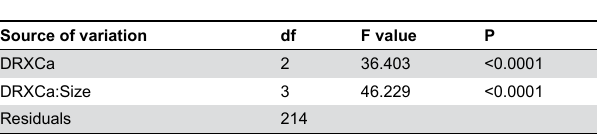
Table 2. ANCOVA performed on shell size (variable) and shell thickness (response) according to soil mineralogy